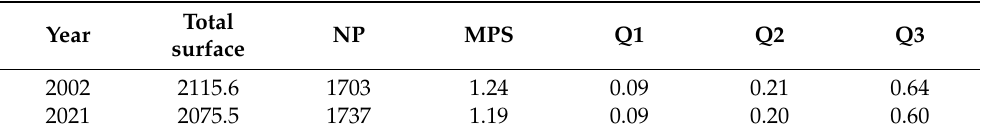
Table 2. Dimensional parameters (in hectares) and total number (NP) of igune and other small woods in 2002 and